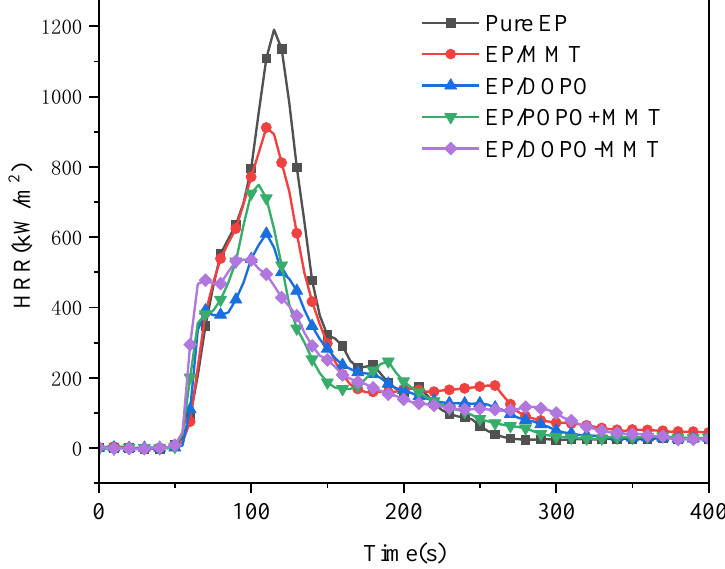
Figure 8. Heat release rate (HRR) curves of epoxy resin composites.